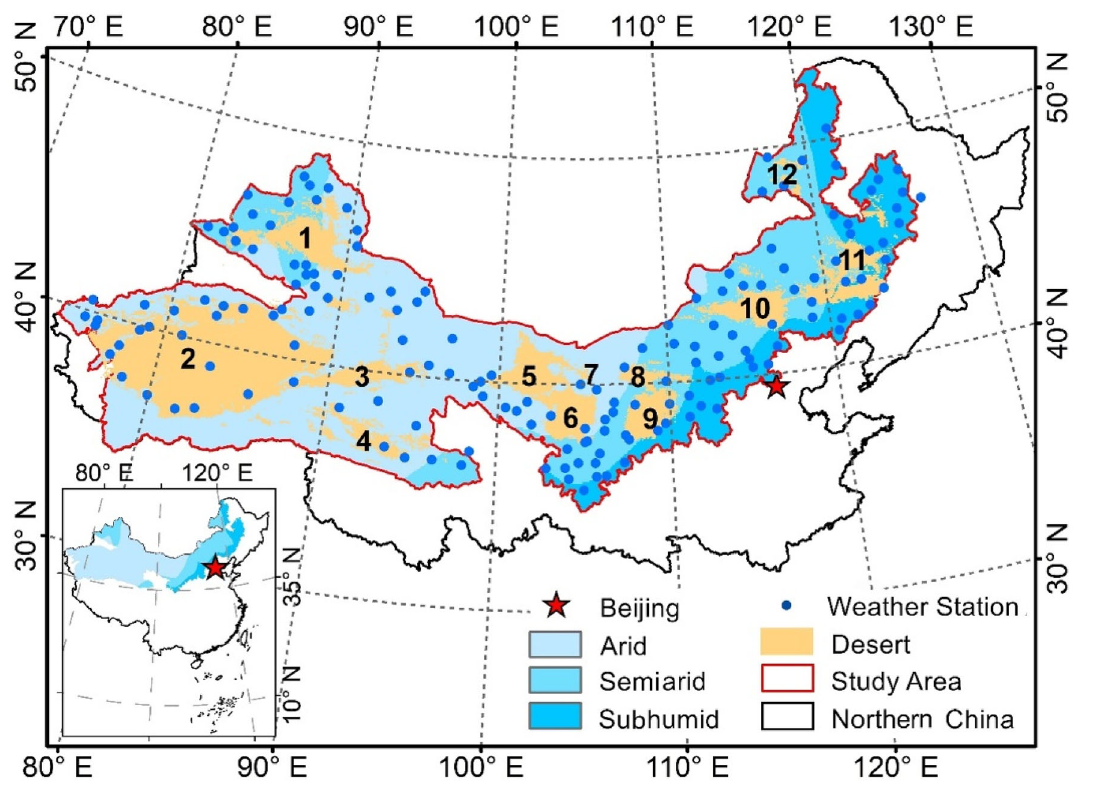
(7), the Hobq Desert (8), the Mu Us Sandy Land (9), the Otindag Sandy Land (10), the Horqin Sandy Land (11), and the Hulunbuir Sandy Land (12). The shaded blue areas are the arid areas, semiarid areas, and subhumid areas in northern China, respectively. Source : After Shi et al.